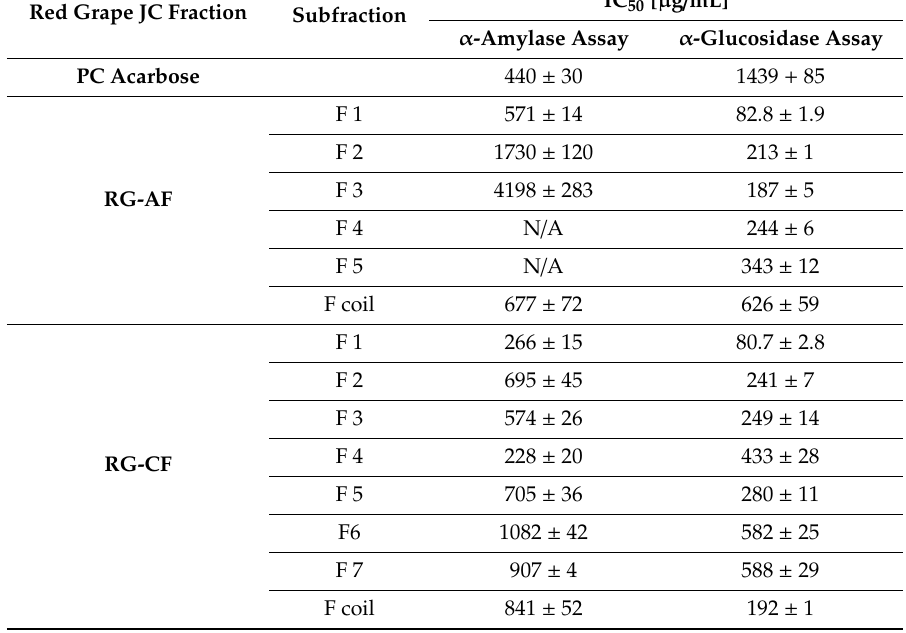
Table 3. Inhibitory activities (IC 50 values) of the HPCCC subfractions of red grape JC anthocyanin (RG-AF) and copigment fraction (RG-CF). Results are presented as means ± SD ( n = 3). N/A = not available.